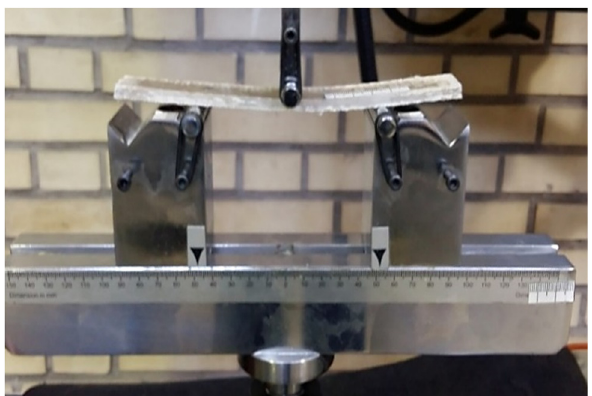
Figure 2: Arrangement of specimens separated by glass separators in the solution. Figure 3: ENF specimen under fracture